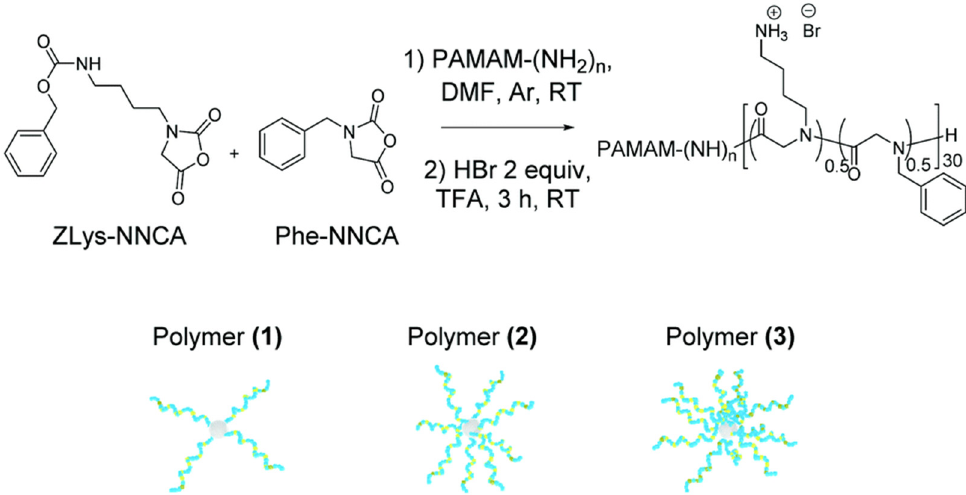
Figure 15. Synthesis of star-shaped poly(sarcosine)s using TREN as initiator (Adapted from ref. [87]. Copyright 2017, Royal Society of Chemistry).